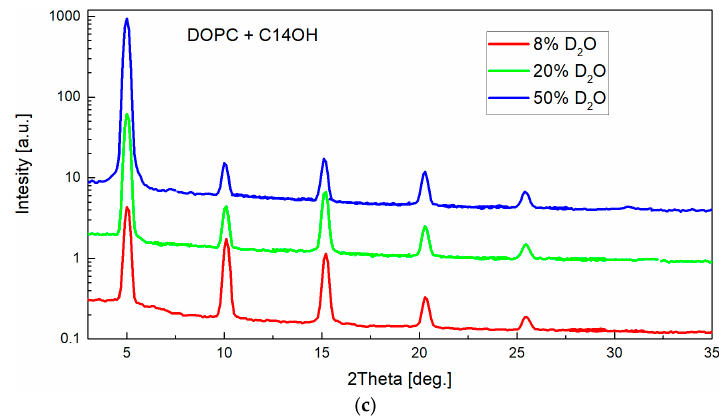
Figure 7. Two-dimensional (2D) image of a typical measurement as recorded at one detector position ( a ) and reduced to rocking curve ( b ) subsequently. The narrow central peak width ( σ G = 0.076) resulting from fitting combination of Gauss and Lorentz function [41] confirms well oriented multilayers. Measurements at several detector positions were integrated into the full diffraction curve covering typically 5–6 diffraction orders ( c ). The relative sizes of various diffraction peaks change with the contrast variation as seen from the comparison of the diffraction curves (note that curves hve been shifted vertically for the clarity of presentation).